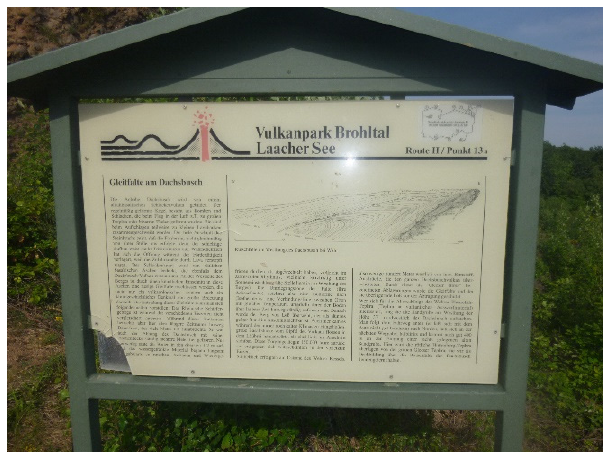
Figure 7. Traditional nature trail panel with too much text (Geopark Vulkaneifel, Germany) (Megerle 2011).